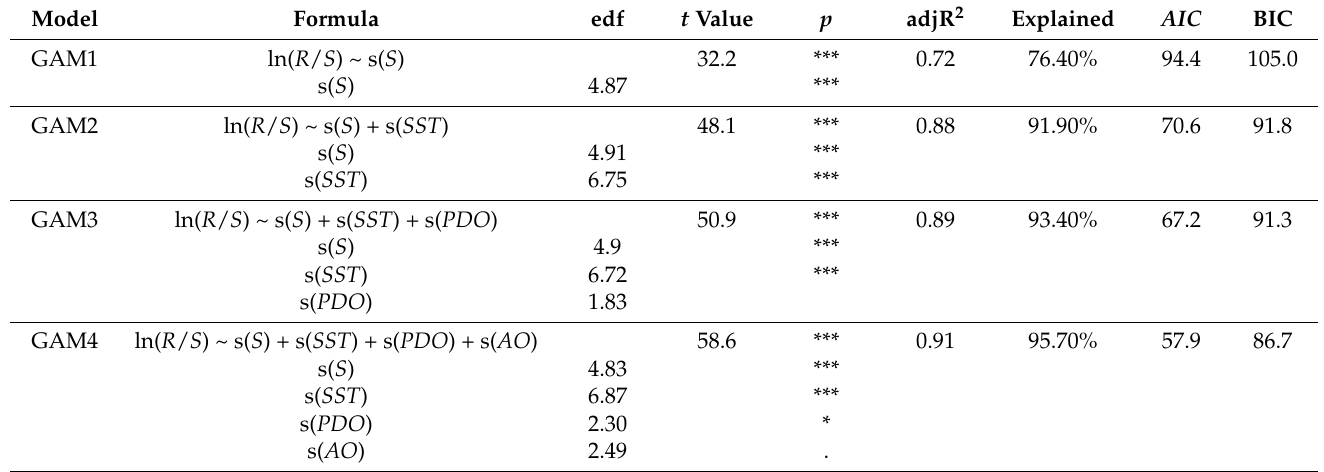
Table 5. Comparison of the best models with different numbers of factors in the GAM. Model